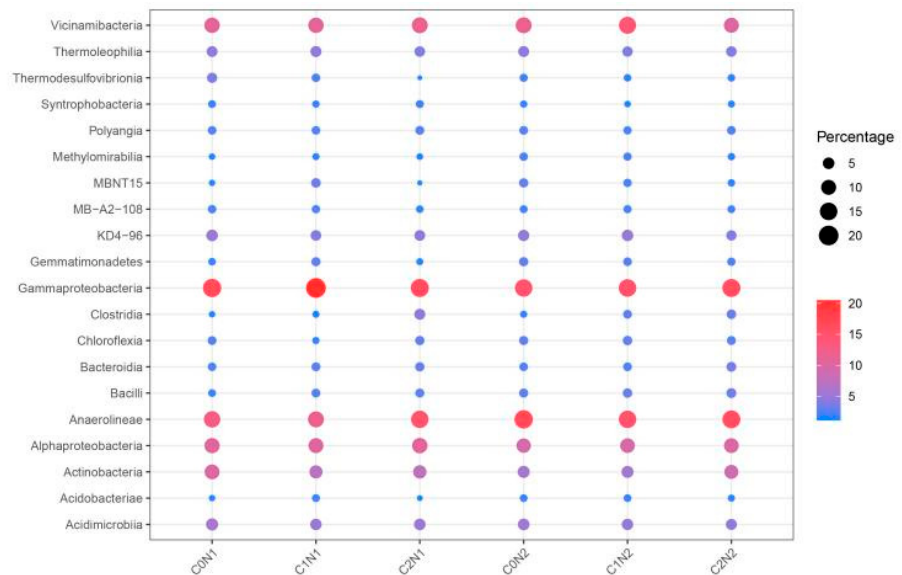
Figure 4. Relative abundance of different bacterial communities at the class levels across all the treatments. The bubble chart indicates the relative abundance of significant enriched class, where red represents higher relative abundance and blue represents lower relative abundance.